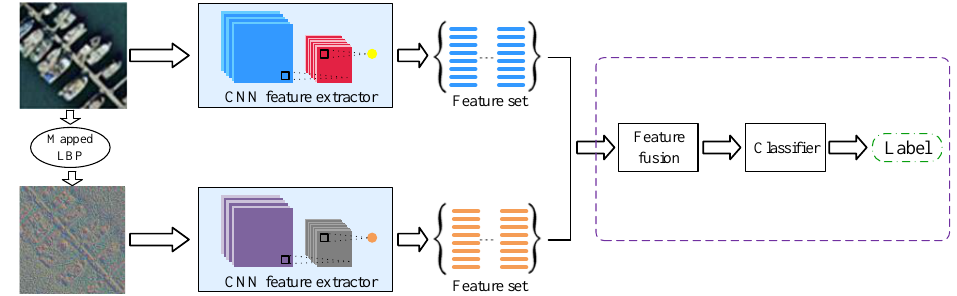
Figure 2. The texture coded two-stream deep architecture. The raw RGB network stream takes RGB images as input. The mapped LBP coded network stream takes mapped LBP images as input. Two differnet sets of features are fused using the two-stream deep feature fusion